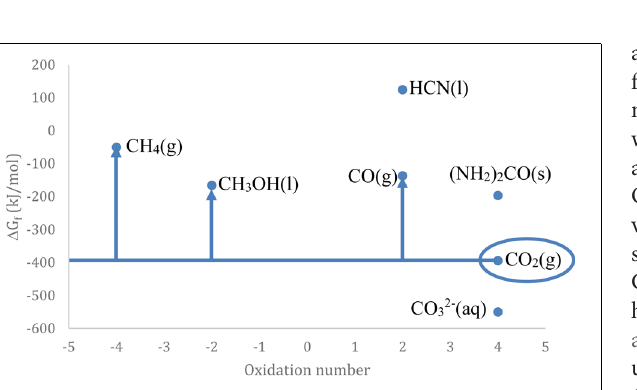
FIGURE 1 | Utilization of CO 2 under solar energy powering of processes (Aresta and Forti, 1987).